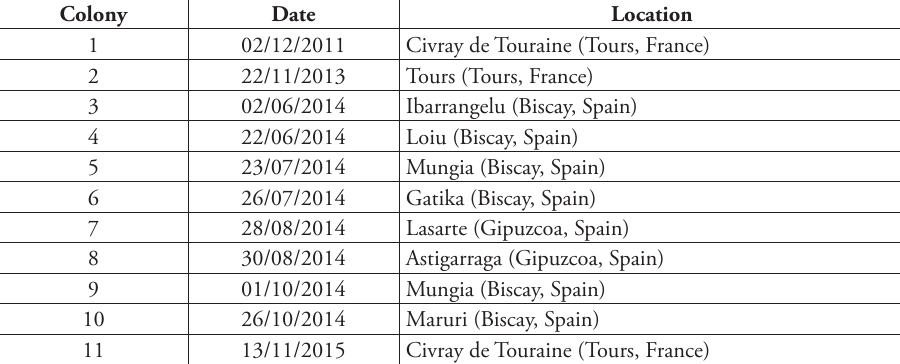
Table 1. Dates and locations of collected colonies. Colony Date